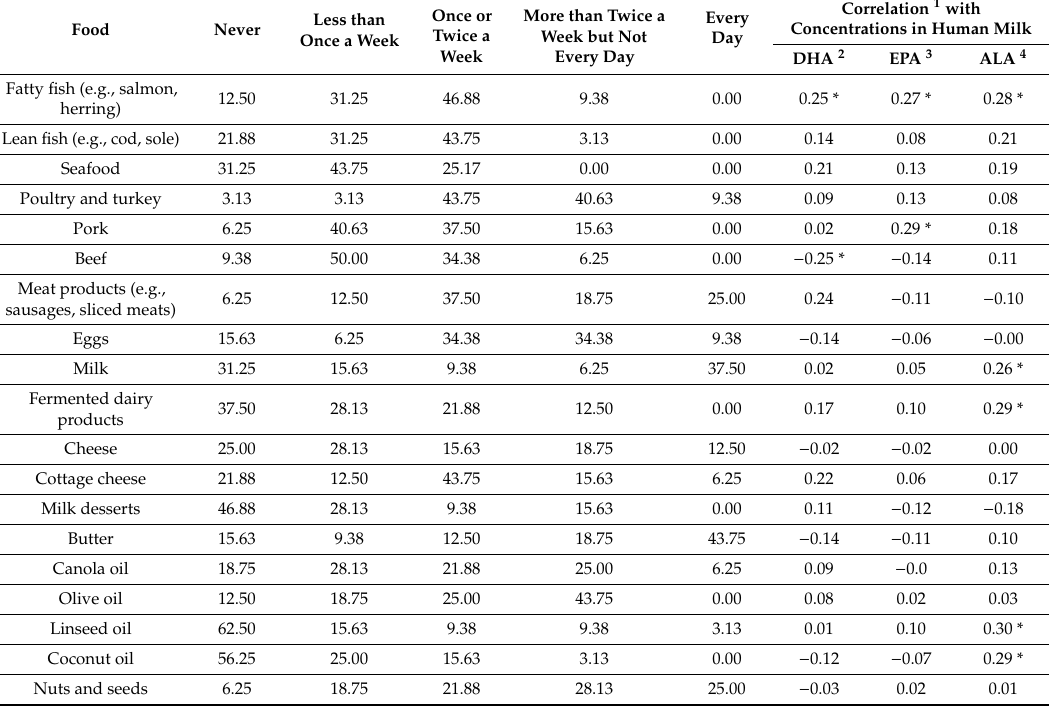
Table 6. Intake frequency (%) of food products and correlations with DHA concentrations in human milk 1